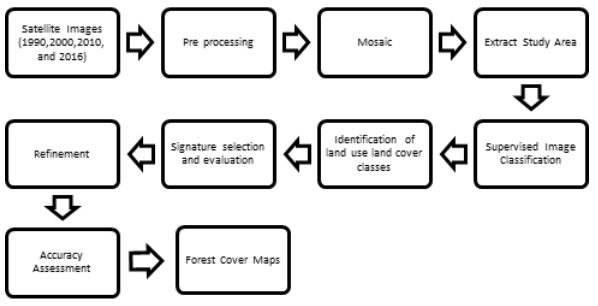
Figure 1 Methodology flow chart for mapping forest